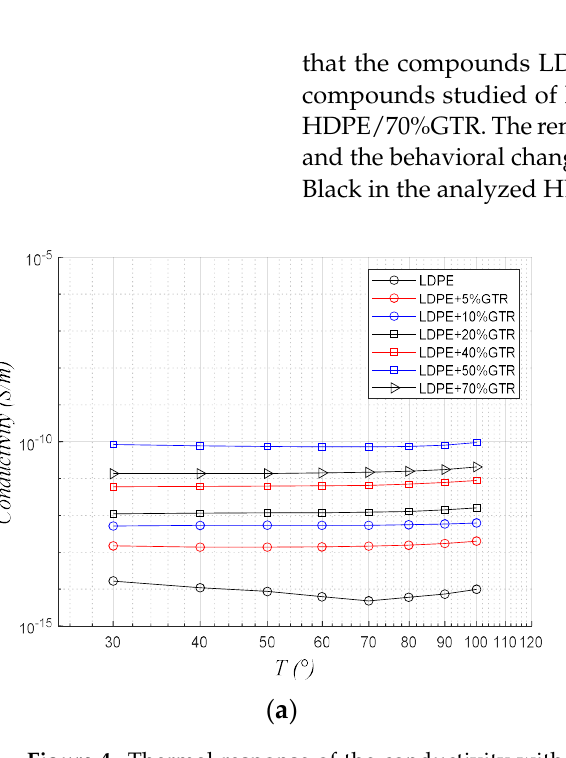
Figure 4. Thermal response of the conductivity with a temperature range of 30 to 100 °C, at 50 Hz, of ( a ) LDPE/GTR compounds and ( b ) HDPE/GTR compounds.